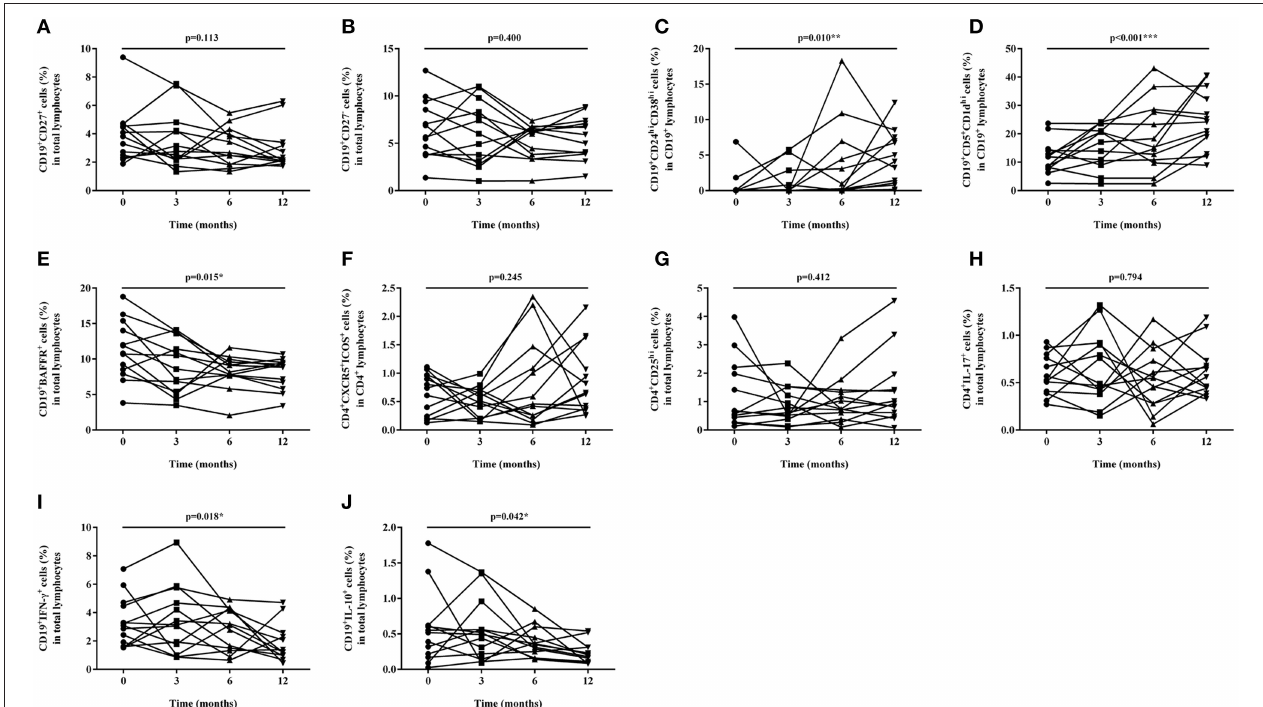
FIGURE 2 | Proportion changes of lymphocyte subsets during baseline and after 3, 6, and 12 months of tacrolimus (TAC) therapy. (A) CD19 + CD27 + memory B cell; (B) CD19 + CD27 − naïve B cell; (C) CD19 + CD24 hi CD38 hi regulatory B cell; (D) CD19 + CD5 + CD1d hi regulatory B cell; (E) CD19 + BAFFR + B cell; (F) CD4 + CXCR5 + ICOS + follicular helper T cell. (G) CD4 + CD25 hi regulatory T cell; (H) IL-17 expressing CD4 + T cell; (I) IFN- γ expressing CD19 + B cell; (J) IL-10 expressing CD19 + B